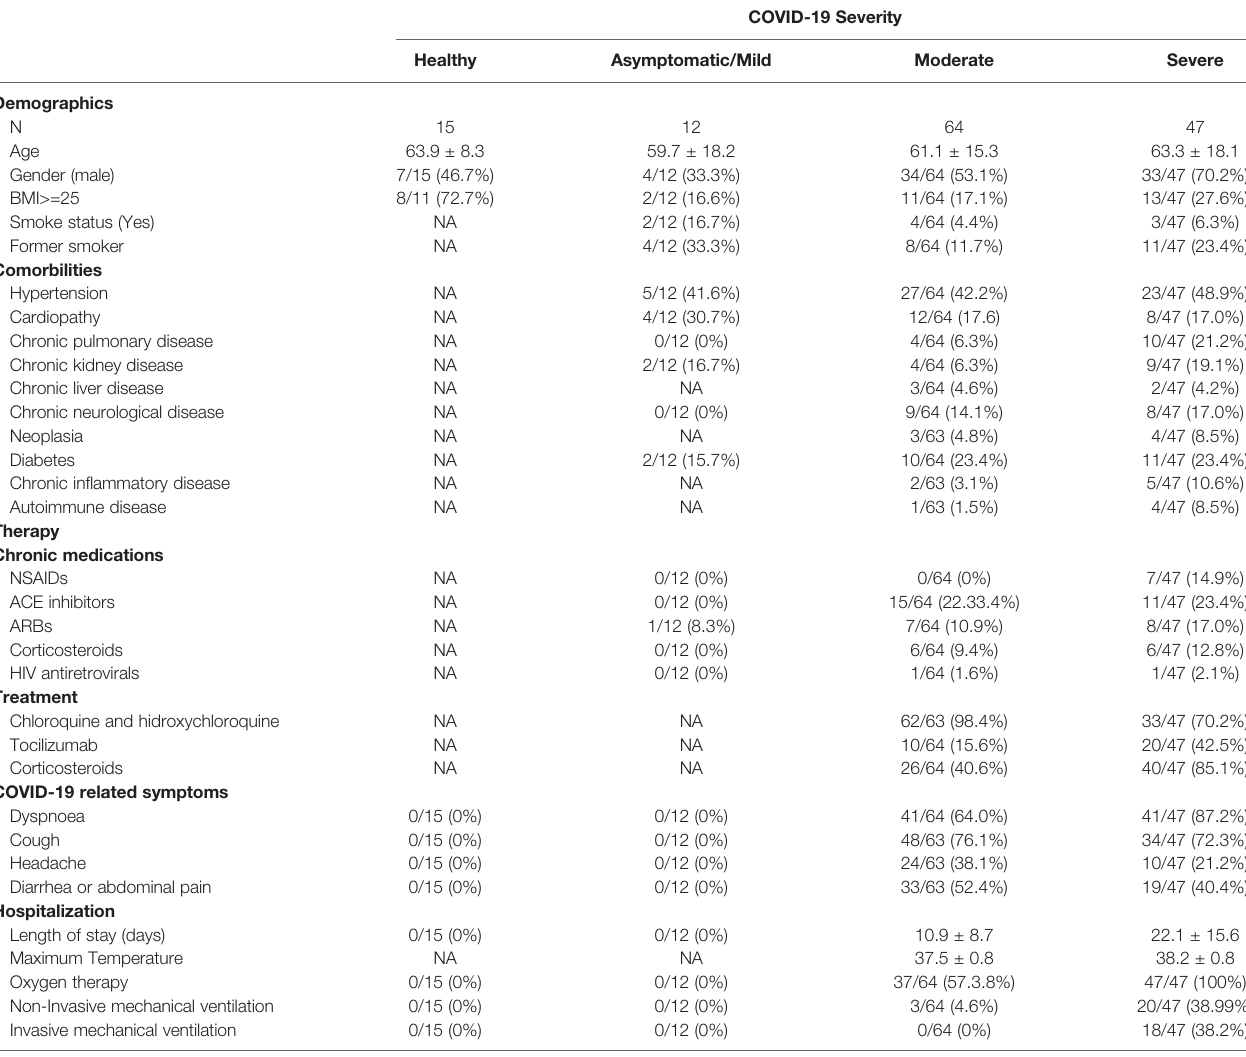
TABLE 1 | Patient ’ s characteristics. Patients were classi fi ed according to the highest disease severity reached during the COVID-19